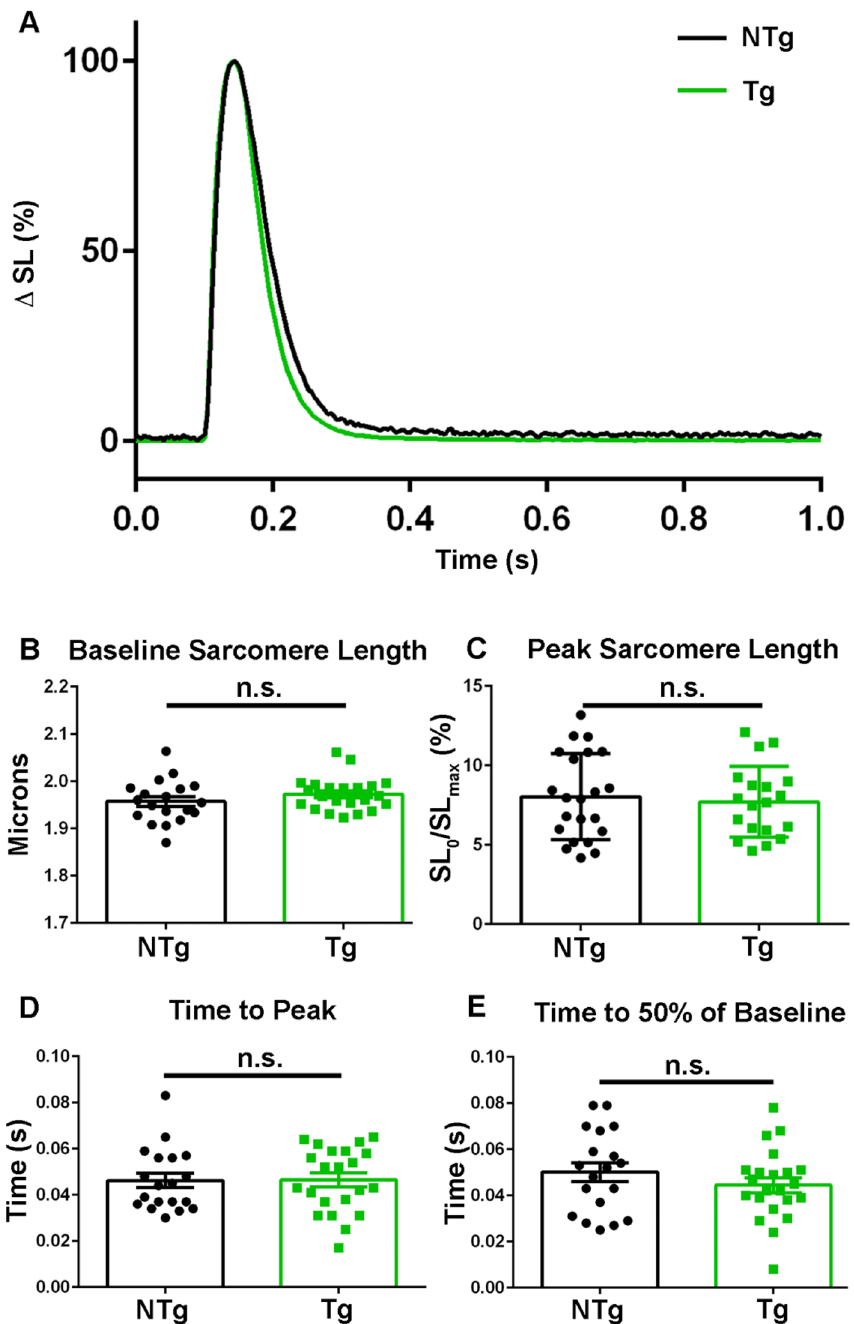
Figure 4. TnC biosensor expression and integration does not impact sarcomere function during a twitch contraction. ( A ) Ensemble average of normalized (0–100%) amplitude of sarcomere length changes during a single twitch contraction for non-transgenic (black) and transgenic (green) isolated FDB fibers. ( B ) Summary statistics of baseline sarcomere length from non-transgenic and transgenic isolated FDB fibers show there is no significant difference between groups. ( C ) Summary statistics for the peak sarcomere length from non- transgenic and transgenic isolated FDB fibers demonstrate there is no significant difference between groups. ( D ) Summary statistics for the time to peak from non-transgenic and transgenic isolated FDB fibers demonstrate there is no significant difference between groups. ( E ) Summary statistics for the time to 50% of baseline in isolated FDB fibers from non-transgenic and transgenic animals show no significant difference between groups. Myofibers measured at room temperature with 0.2 Hz stimulation, NTg: n = 19 fibers from n = 3 animals and Tg: n = 26 fibers from n = 7 animals. Mean ± S.E.M. are presented, * P <